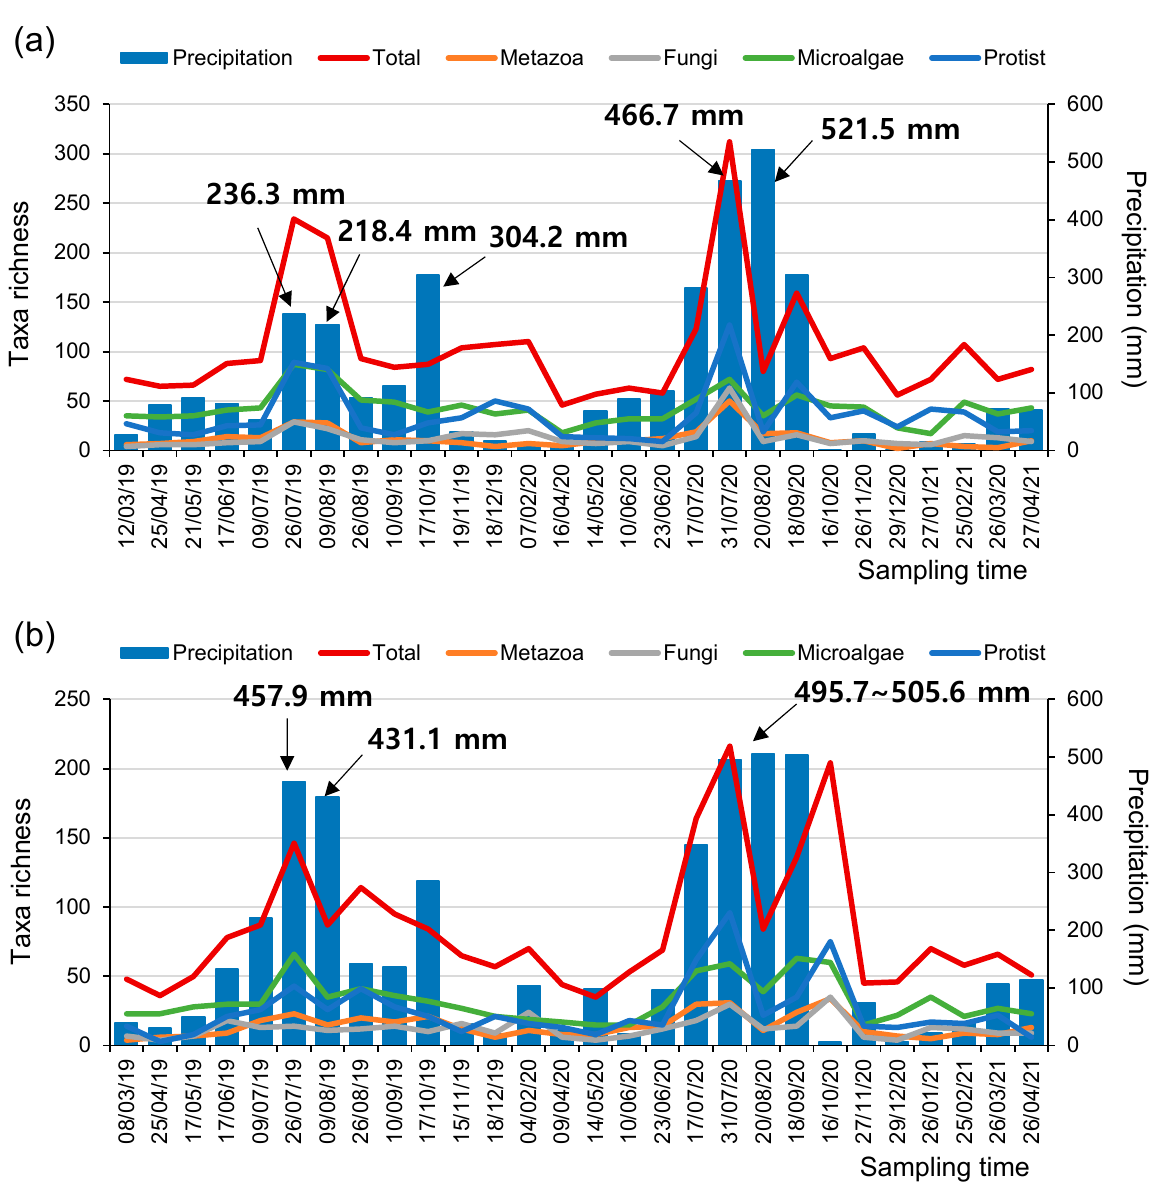
Figure 3. The number of taxa in microeukaryome groups and the amount of monthly precipitation (mm) at the ( a ) SJ and ( b ) MG sites during the study periods.